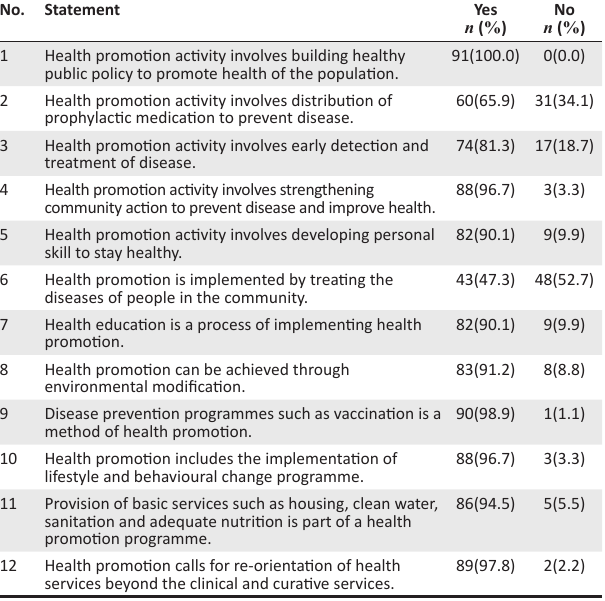
TABLE 4: Physiotherapists’ knowledge of health